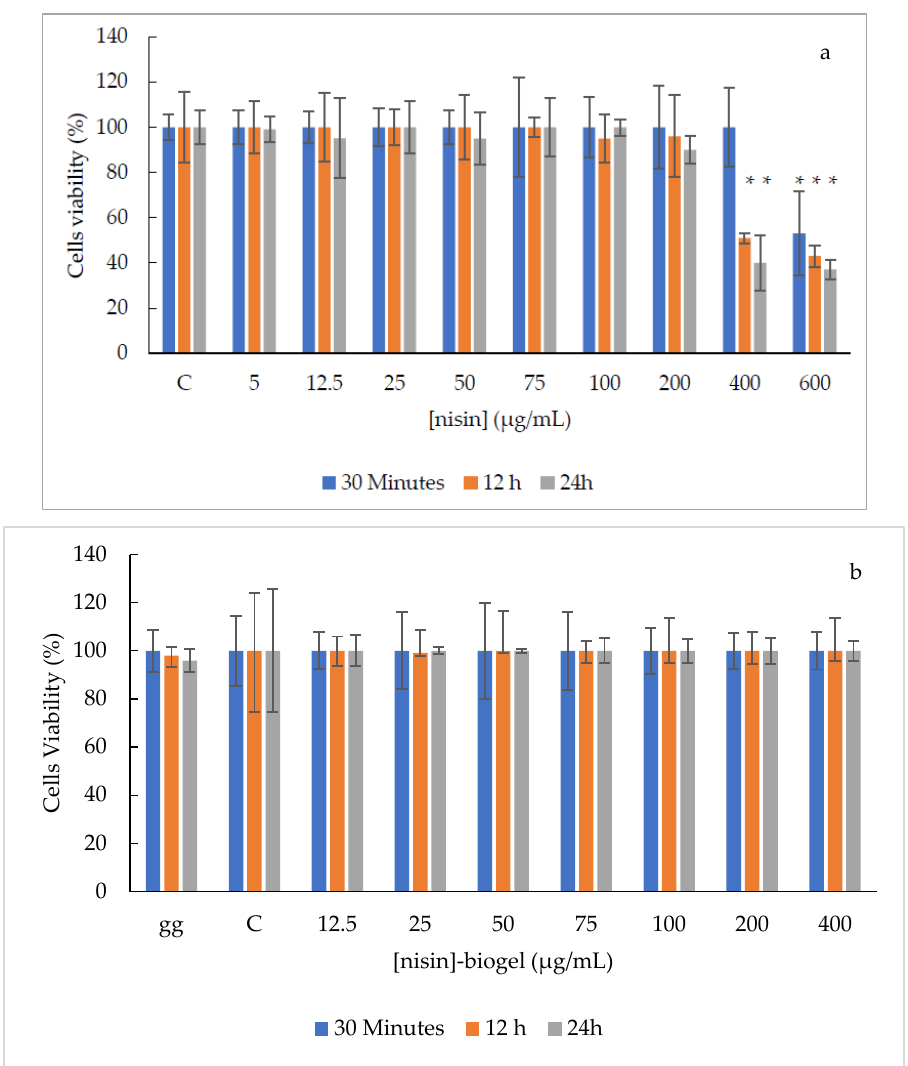
Figure 3. Canine primary small intestinal fibroblast cells viability (%), after three treatment periods (30 min, 12 h and 24 h) with nisin and nisin-biogel solutions. a —Distribution of cells viability (%) after exposure to nisin at concentrations ranging between 5 to 600 µg/mL, after three treatment periods. b —Distribution of cells viability (%) after exposure to nisin-biogel at concentrations ranging between 12.5 to 400 µg/mL after three treatment periods. C—negative control with no treatment. gg—control with non-supplemented biogel. The vertical bars represent standard deviations of the means.* p -value ≤ 0.05.